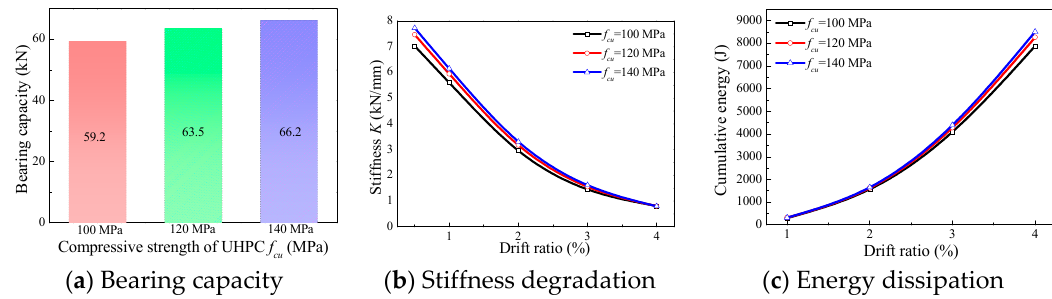
Figure 15. The e ff ect of the compressive strength of UHPC.